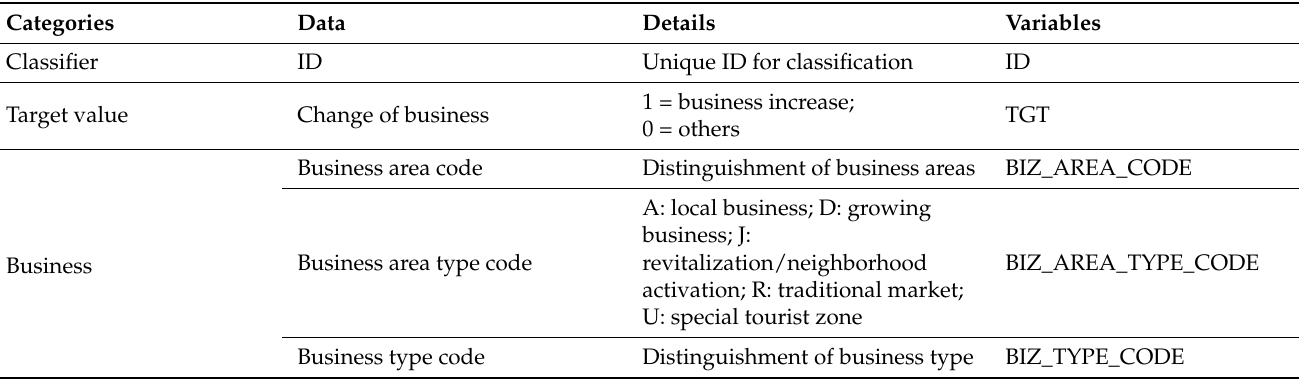
Table 4. Summary of datasets.